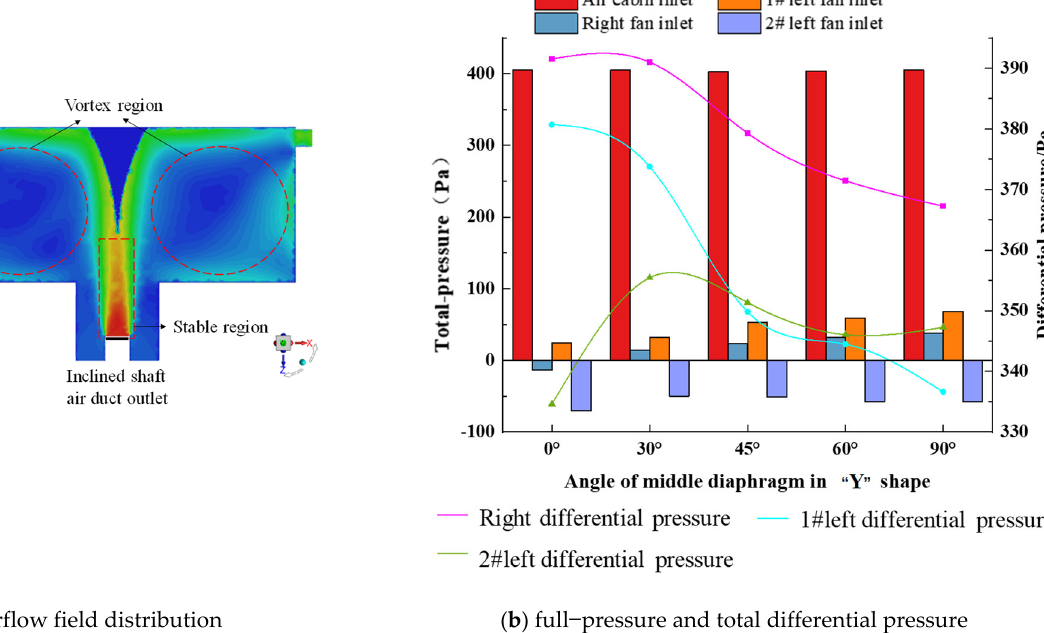
Figure 15. Airflow field distribution and differential pressure in different angles of the middle diaphragm.